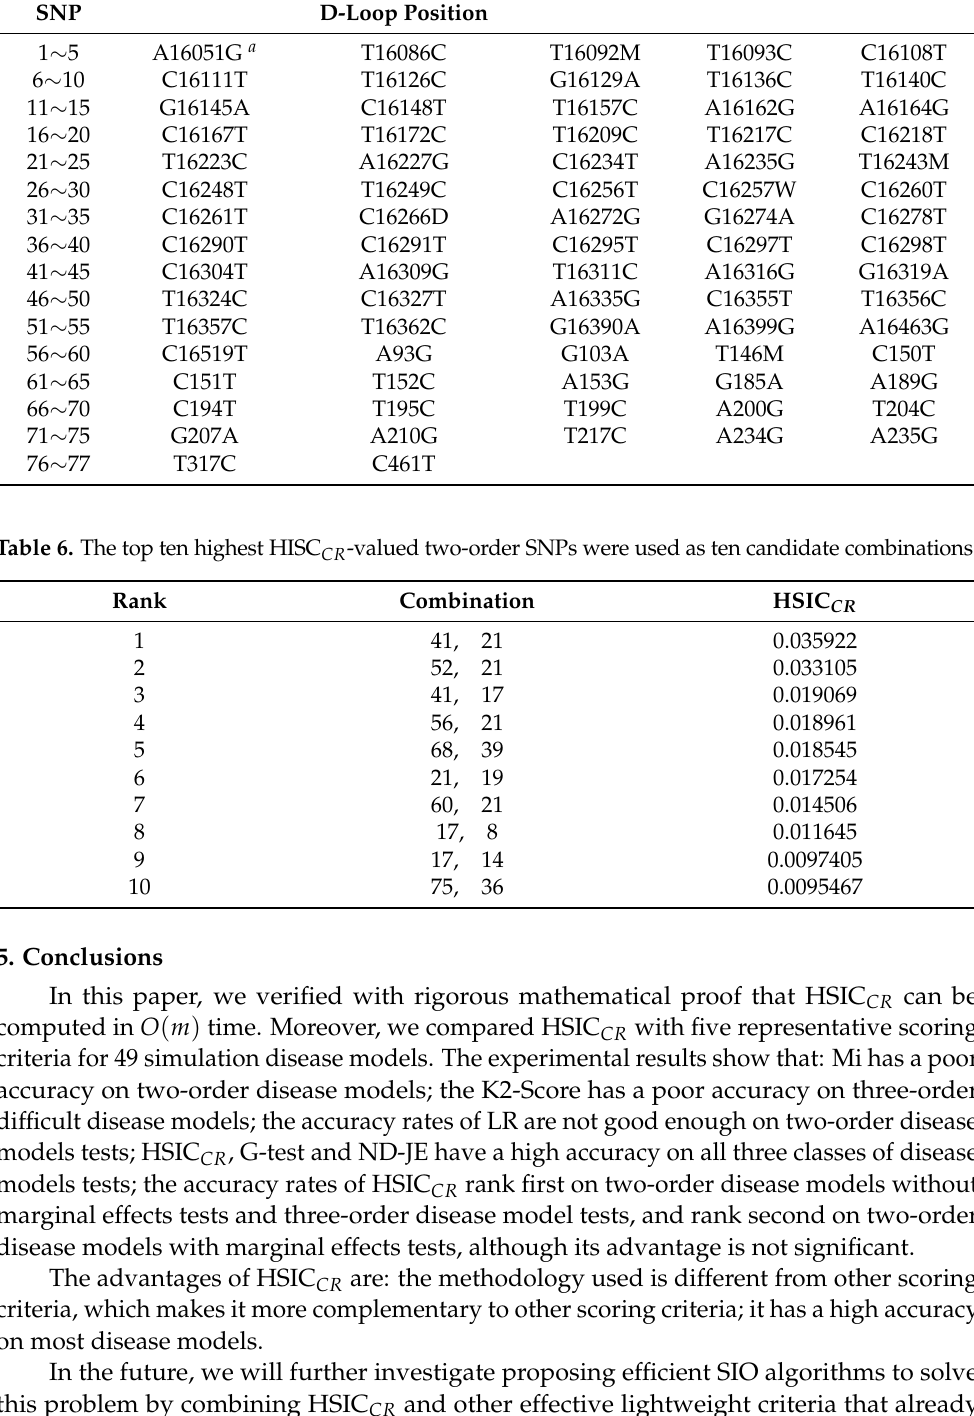
Table 5. Positions of chronic dialysis-associated 77 SNPS in mitochondrial d-loop region. a Left and right letters are major and minor genotypes, respectively. The number is the SNP position in the mitochondrial D-loop region. SNP D-Loop Position 1 ∼ 5